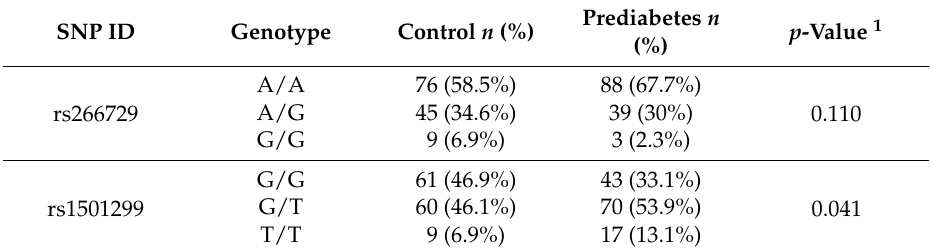
Table 4. Genotype frequencies of rs266729, rs1501299 and rs2241766 SNPs in control and prediabetic subjects.